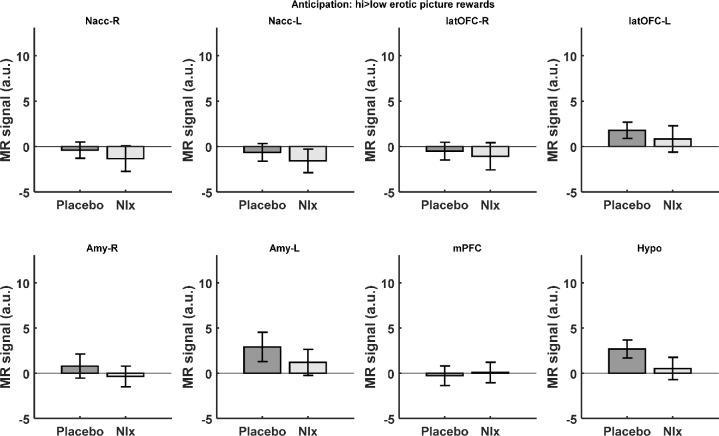
Region of interest contrasts of brain activity for high versus low erotic picture reward anticipation for placebo and naloxone treatment.